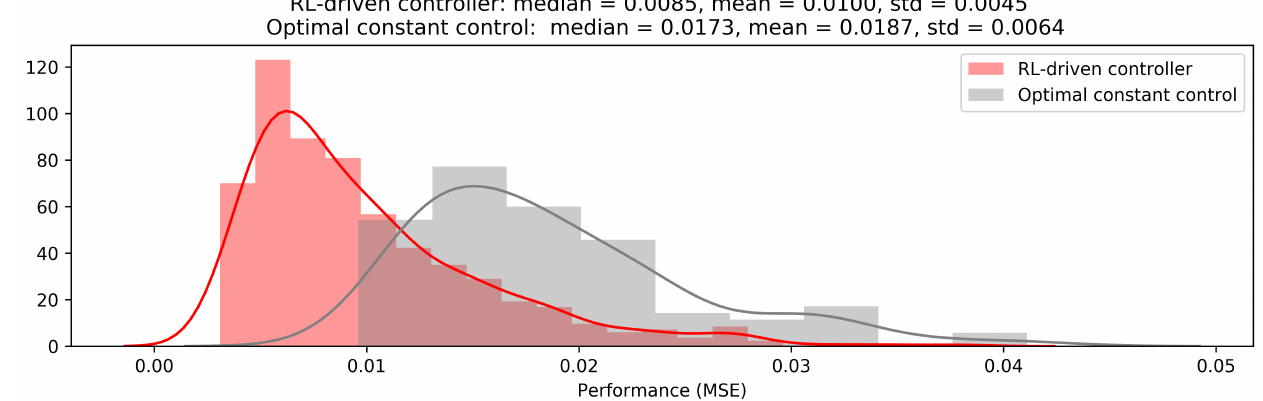
Figure 12. Performance metric (MSE) distribution for the developed RL controller and the competing approach (proportional control) for the 40 TCLs setup.